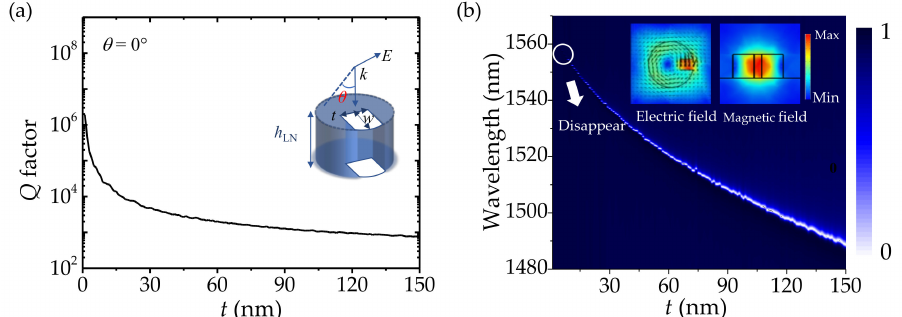
Figure 3. ( a ) The dependence of the Q factor on defect size t of the asymmetric LiNbO 3 cylinder. Inset: the schematic diagram of a single asymmetric LiNbO 3 cylinder. ( b ) Simulated transmission spectrum as a function of defect size t . Top inset: electric and magnetic field distributions in the asymmetric LiNbO 3 cylinder.